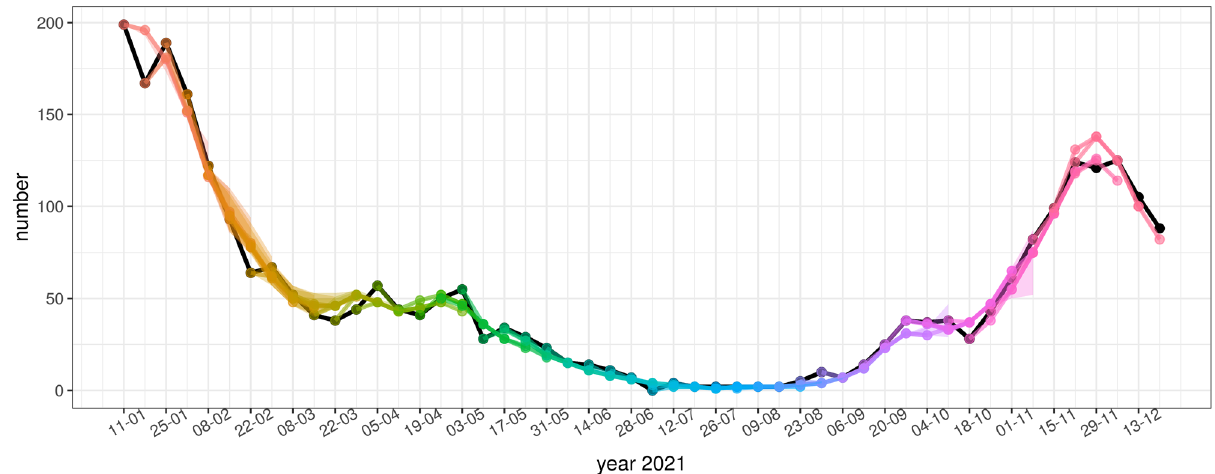
Figure 6. Model forecasts of weekly incidence of deaths due to COVID-19. The representation is the same as in Fig. 4.